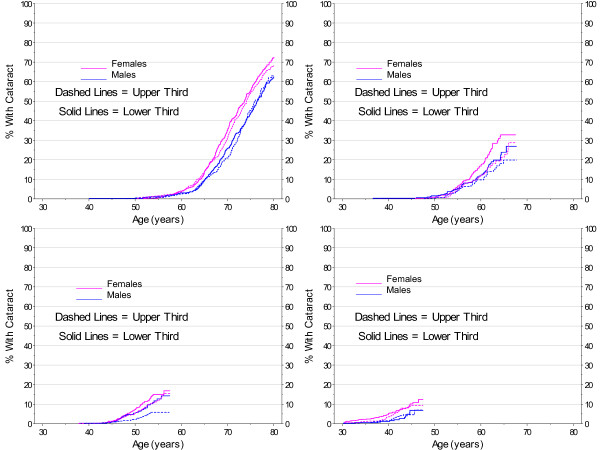
Kaplan-Meier Estimates for Cataract Incidence by BMI (lower vs. upper third), Gender, and Birth Cohort with No Diabetes.